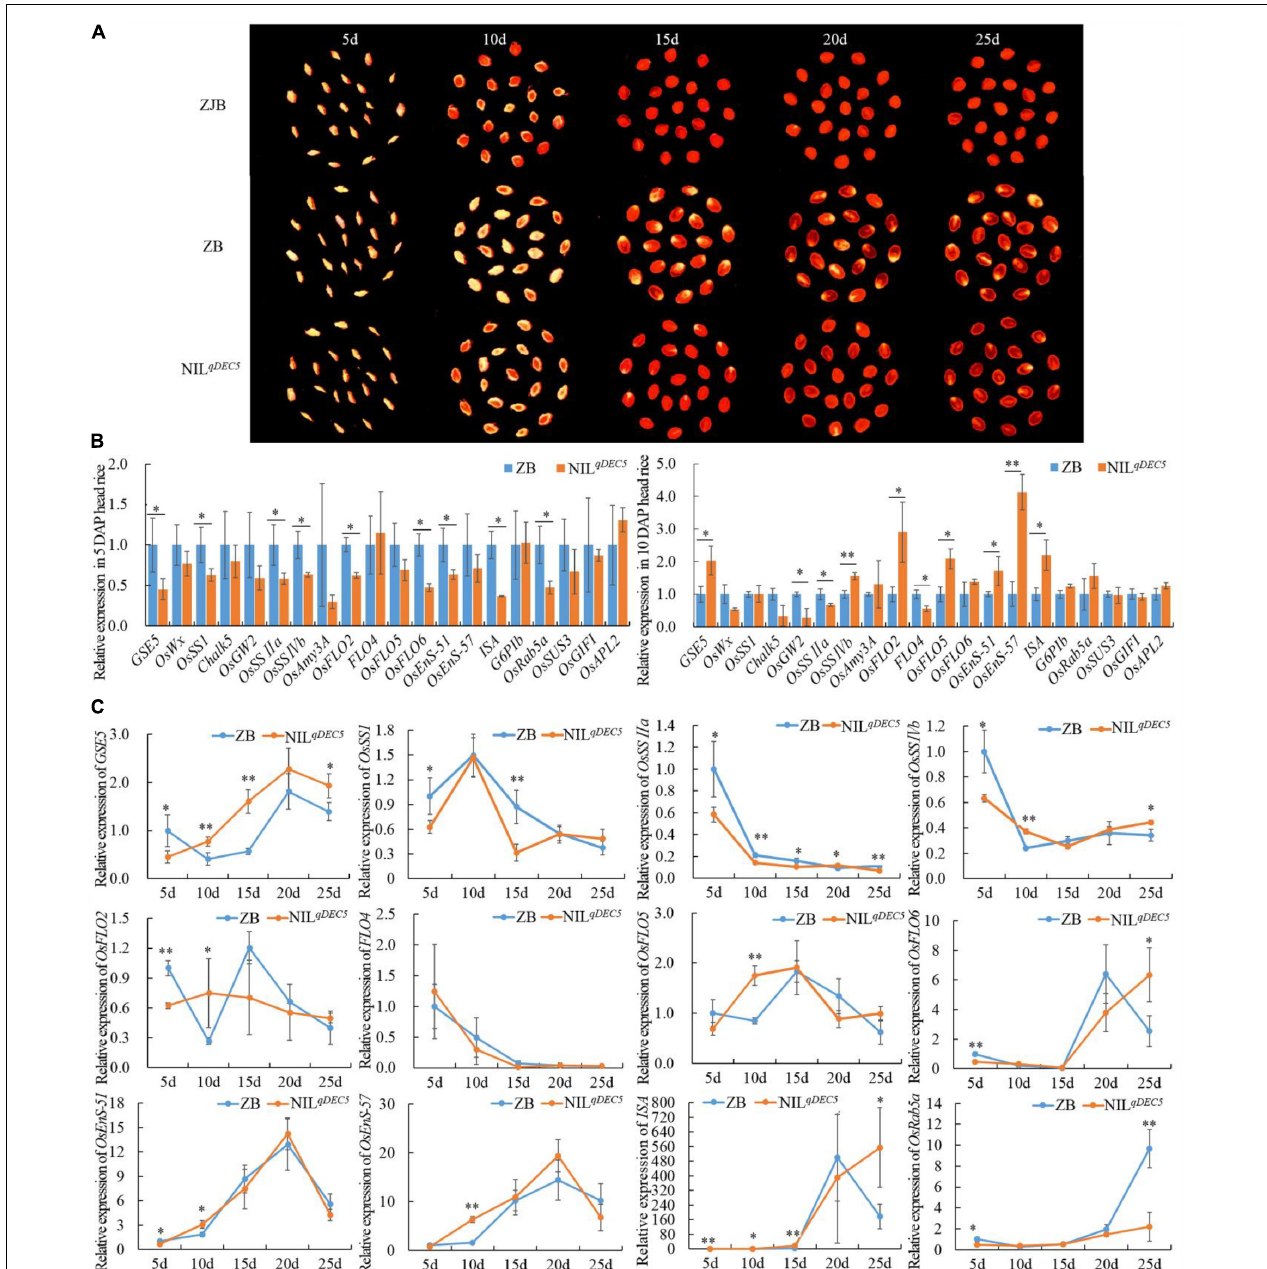
FIGURE 6 | The dehulled developing caryopsis and the relative expression of GSE5 and genes related to chalkiness or starch metabolism during the process of seed development. (A) The dehulled caryopsis cross-section of ZJB, ZB, and NIL qDEC 5 at different developmental stages was obtained by the negative scan function of the HP ScanJet G4050 scanner. The yellowish-white spot is the floury or chalky part in the endosperm. (B) The relative expression levels of genes related to chalkiness or starch biosynthesis during the process of seed development. ZB expression represents 1. (C) Time course analysis of genes’ expression during the process of seed development. ZB expression at 5 DAP represents 1. Significance was determined by analysis of variance (ANOVA) ( ∗ P < 0.05 and ∗∗ P < 0.01). Error bar shows the SD ( n = 3); DAP, day after pollination.